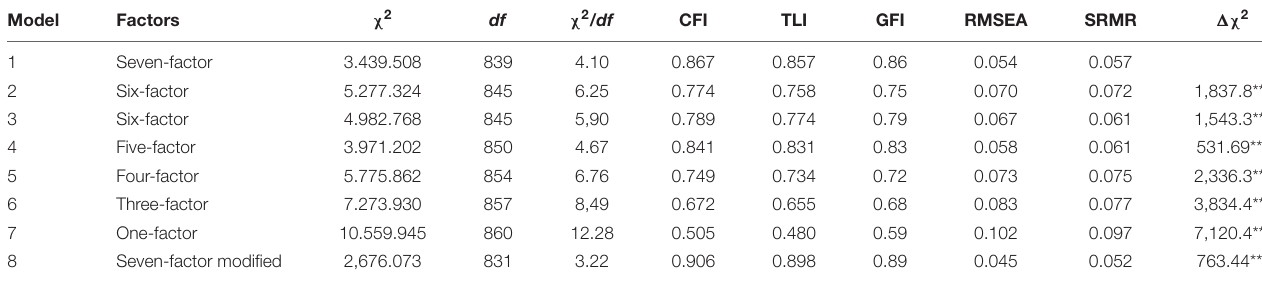
TABLE 3 | Confirmatory factor analyses and fit